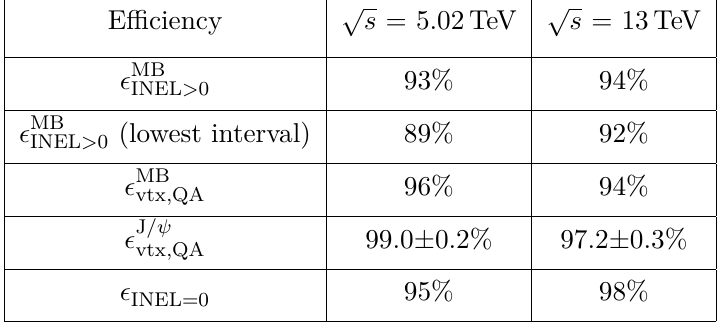
Table 2 . The various efficiency factors which are applied to calculate the relative yield of J /ψ along with their statistical uncertainty. The values quoted without uncertainty have negligible statistical